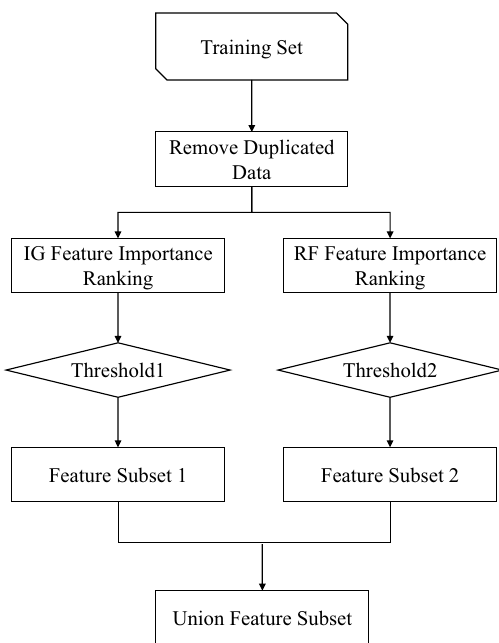
Fig. 3 Workflow of ensemble feature selection with IG and